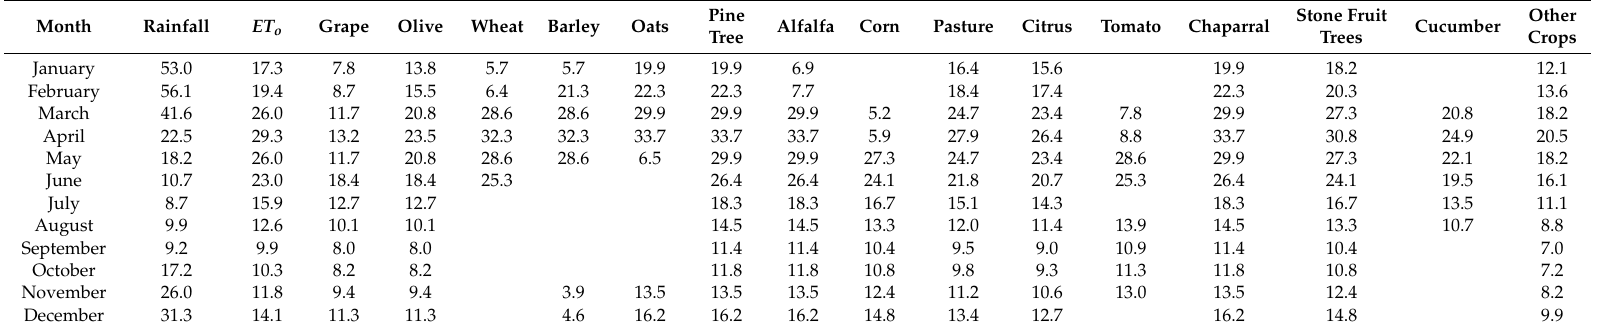
Table 4. Average Multi-annual Monthly Rainfall, ET o and ET c of the crops in the area in